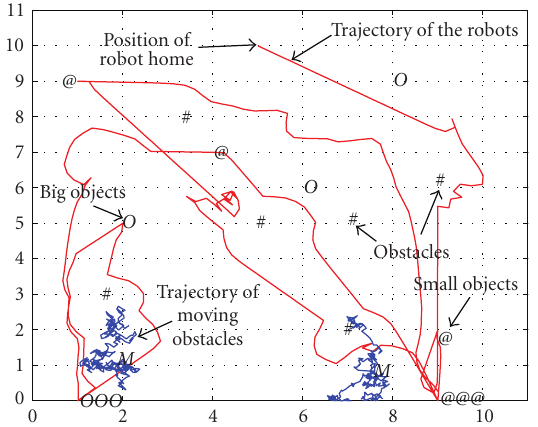
Figure 9: This figure is the snapshot after the task is completed. All three big objects are returned to the big object collection position and all three small objects are returned to the small object collection position. The robots are back in their home position. The dashed line represents the trajectory of agent R 3.